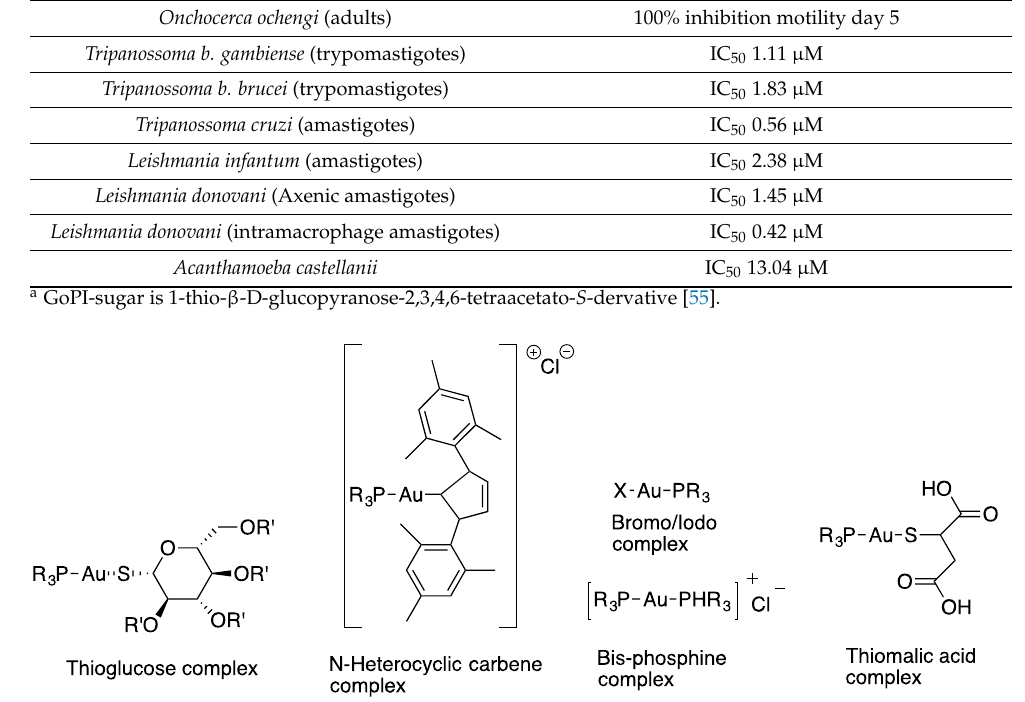
Figure 8. Gold(I) phosphine complexes.